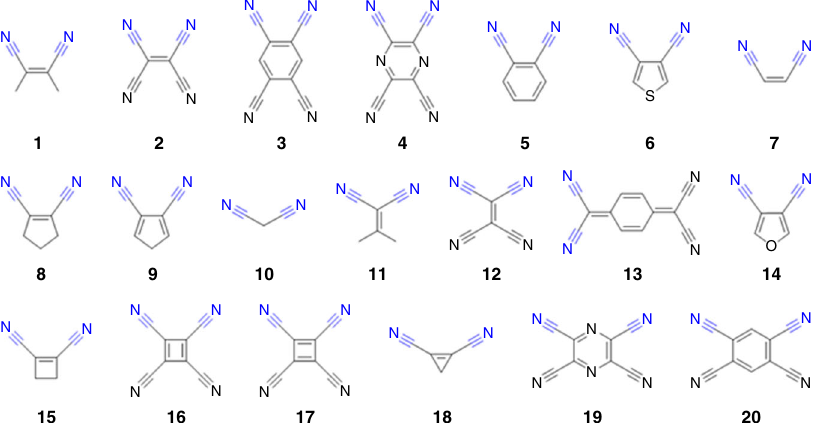
Fig. 3 Library of potential CLs evaluated with RetroFit. Structural parameters were obtained from geometry optimized structures in the gas phase. The coordinates can be found in the program package provided in the Supplementary data fi les